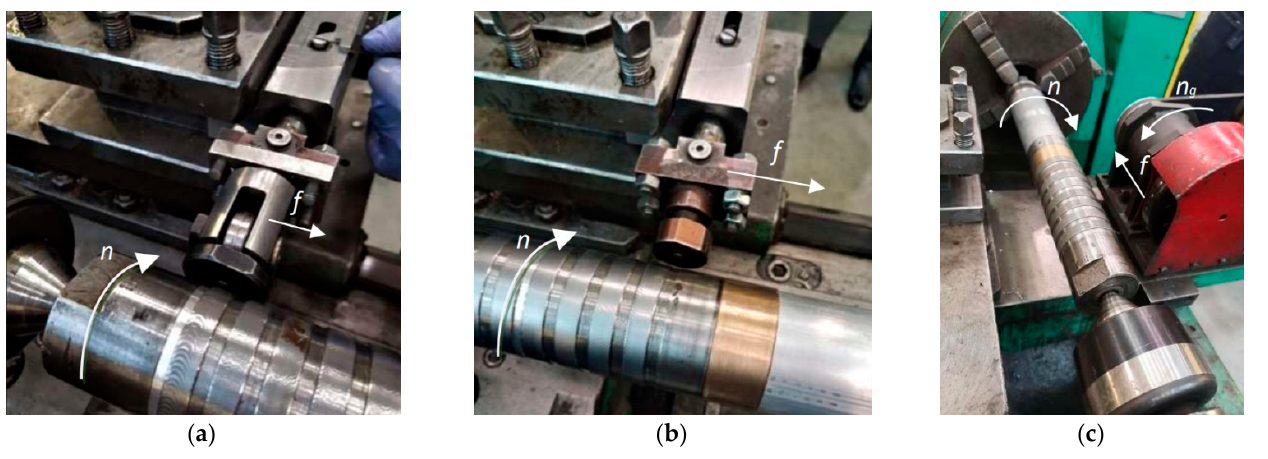
Figure 2. View of the stands and tools used in the experiment: ( a ) ball burnishing, ( b ) slide burnishing, ( c ) centrifugal shot peening ( f —feed, n —rotational speed of the sample, n g —rotational speed of the head).